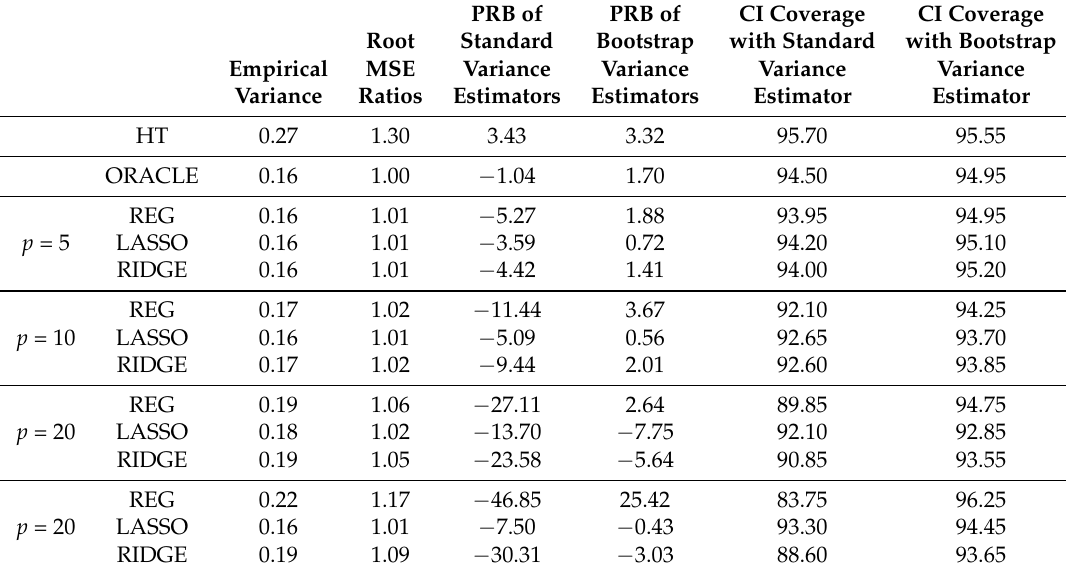
Table 3. Simulation Results: Ratio of root mean squared errors compared to ORACLE (Root MSE Ratios), percentage relative bias (PRB) of standard and bootstrap variance estimators, confidence interval (CI) coverage for nominal 95% confidence